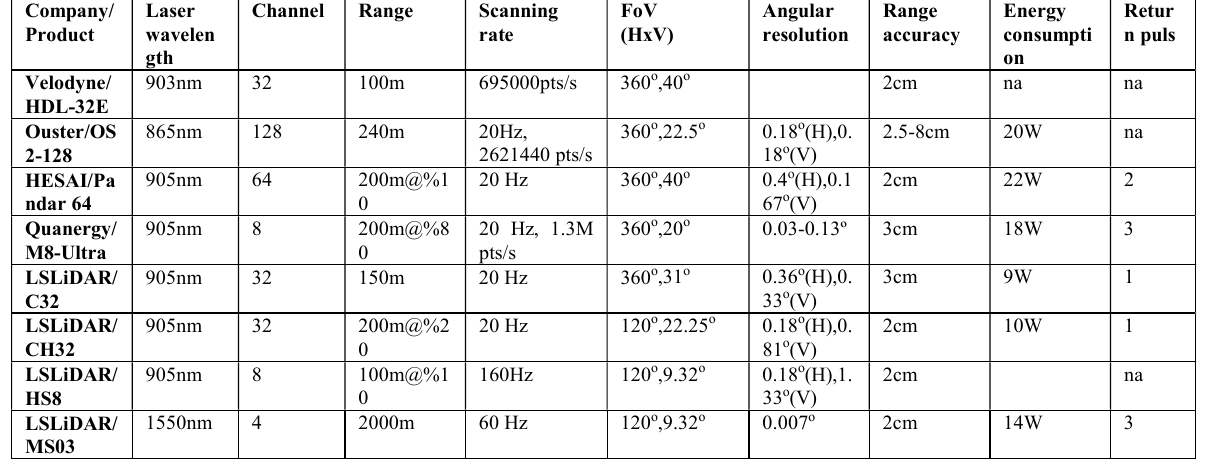
Table 3. Technical specifications of multi-beam LiDAR.